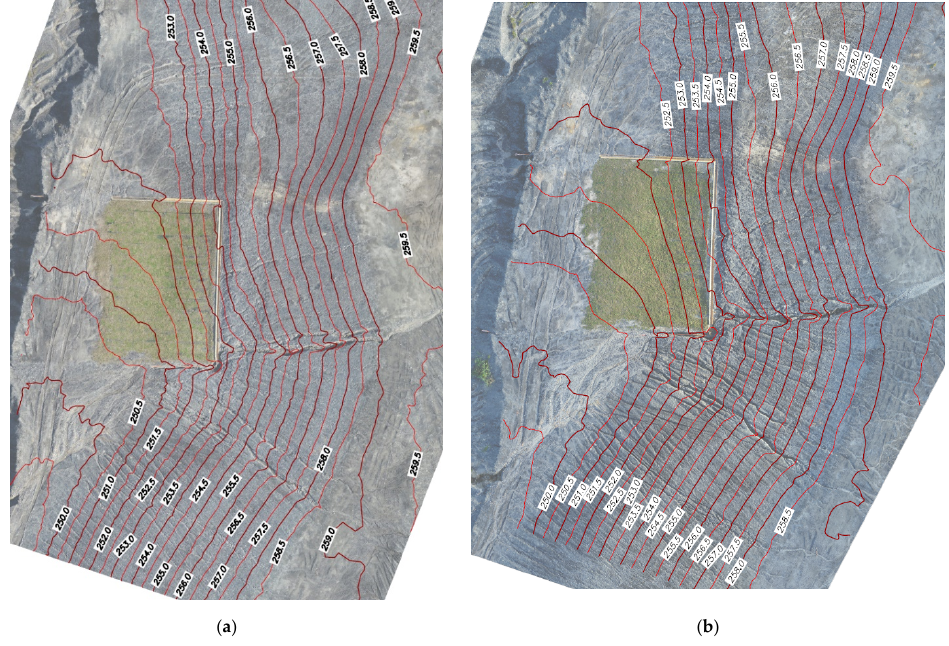
Figure 13. Orthophoto maps with contour lines of the studied site: ( a ) 19 April 2022; ( b ) 11 August 2022.